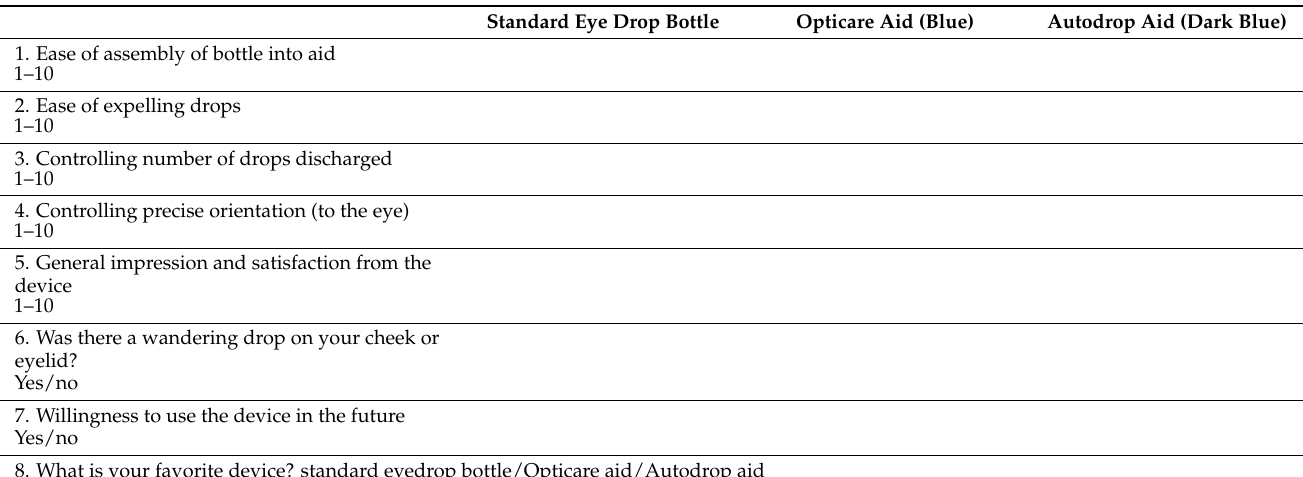
Table 1. Patient’s questionnaire. Examinee number: _________. Please answer the questions below. Your response should be from a scale of 1–10 (10—best experience, easy to use; 1—worst experience, difficult to